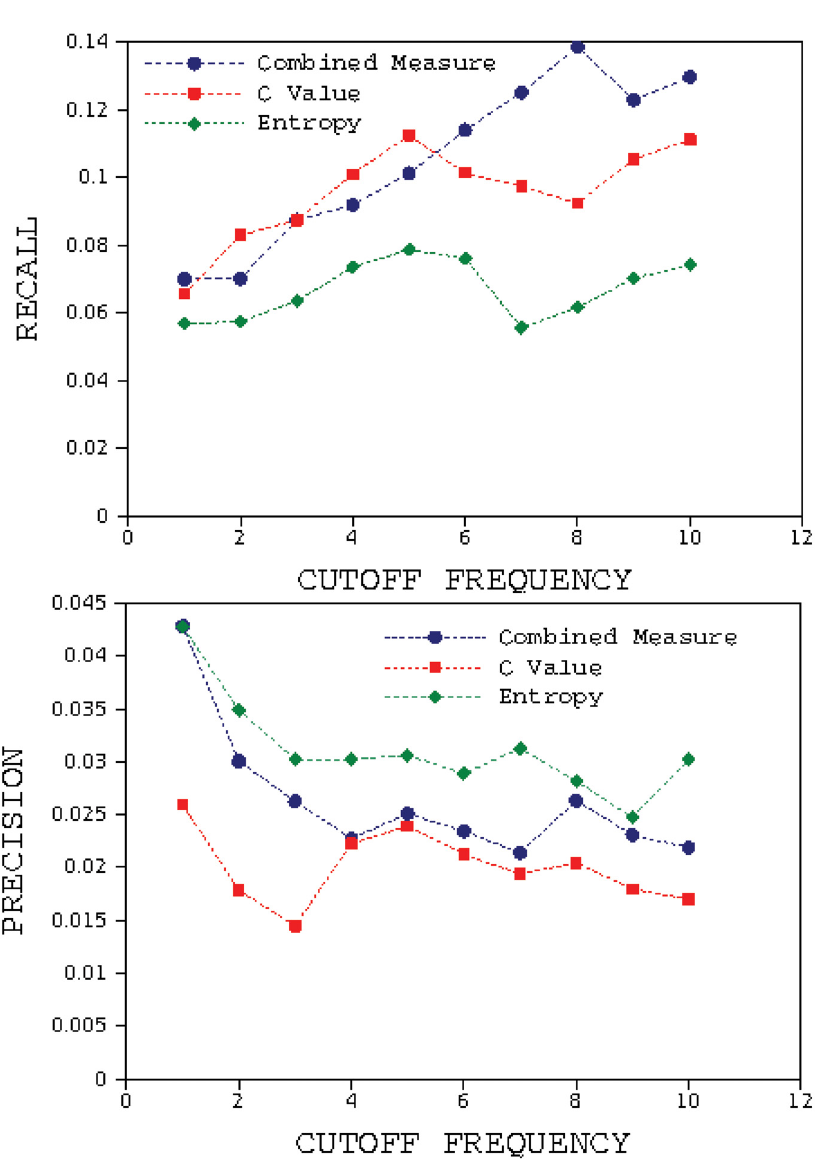
Fig 9. Results of calculating Recall and Precision with Herrera and Purri approach for the book The Origin of Species for 10 cut-off frequencies. The fractal method has the highest value of Recall in all frequencies and higher value of Precision than C Value